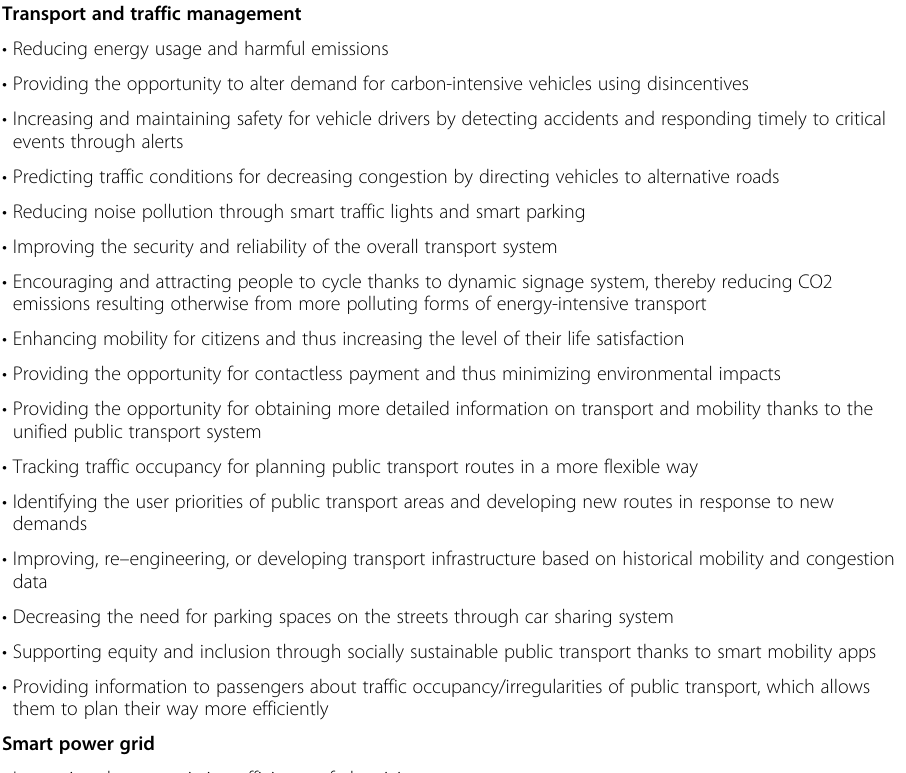
Table 6 The key benefits, potentials, and opportunities of the data-driven smart city and the environmentally data-driven smart sustainable city Transport and traffic